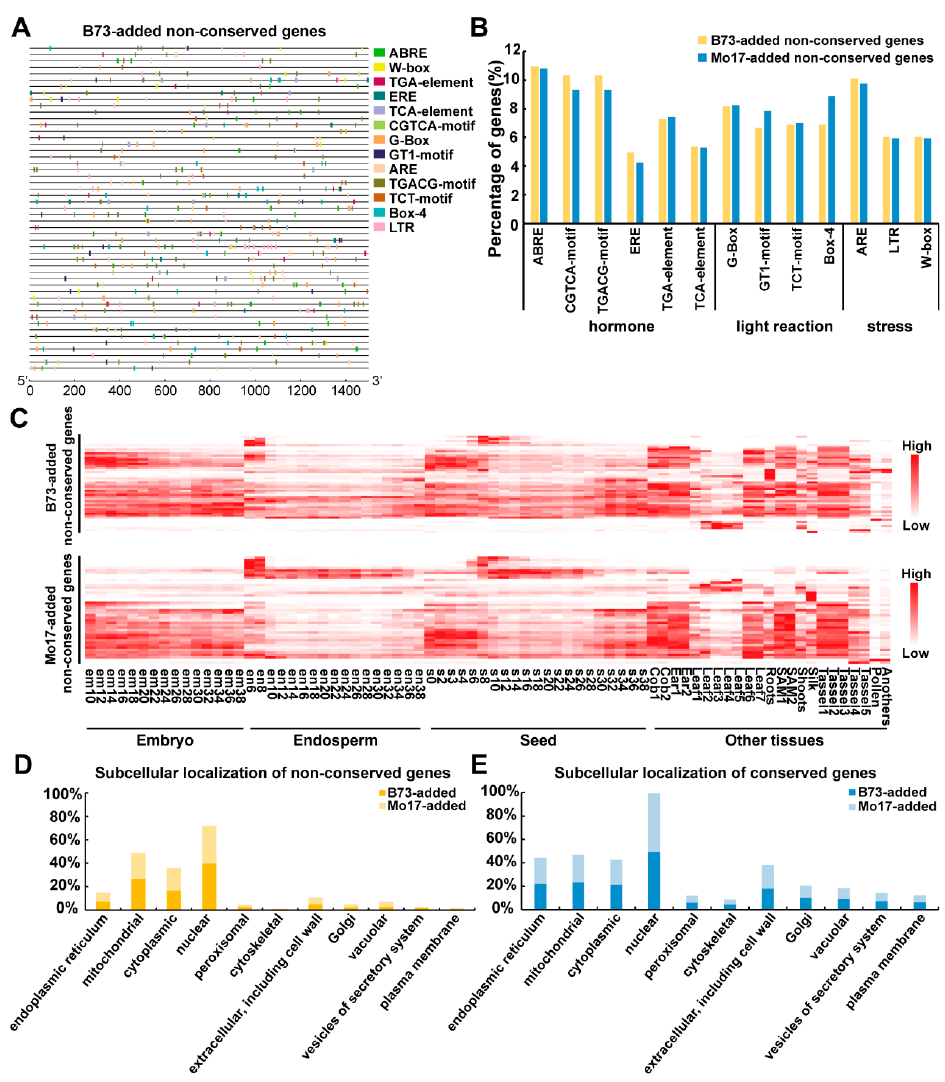
Figure 3. The cis-element distribution, gene expression level and subcellular localization of proteins encoded by conserved and non-conserved imprinted genes of the B73-added group and the Mo17- added group. ( A ) The cis-element distribution in the promoter sequence of the 51 non-conserved imprinted genes detected in the B73-added group; distribution of cis-acting elements related to hormones, light and stress in the promoter sequences of the 51 genes. Putative ABRE, W-box, TGA- element, ERE, TCA-element, CGTCA-motif, G-box, GT1-motif, ARE, TGACG-motif, TCT-motif, Box 4 and LTR core sequences are represented by different symbols, as indicated in the legend on the right. The 1.5 kb sequences upstream of the initiation codon (ATG) of the imprinted genes were estimated using the scale per 300 bp above. ( B ) The ratio of each cis-element in the two groups of non-conserved genes. Yellow and blue rectangles represent the B73-added and Mo17-added non-conserved groups. ( C ) The expression of the imprinted genes detected in the B73-added and Mo17-added non-conserved groups. ( D , E ) The subcellular localization of proteins encoded by non-conserved ( D ) and conserved ( E ) imprinted genes in the B73-added and Mo17-added non-conserved groups. The Y -axis represents the percentage of proteins located in each organelle. Yellow indicates proteins encoded by genes in the Mo17-added non-conserved group; dark-yellow indicates proteins encoded by genes in the B73- added non-conserved group; blue indicates proteins encoded by genes in the Mo17-added conserved group; and dark blue indicates proteins encoded by genes in the B73-added conserved